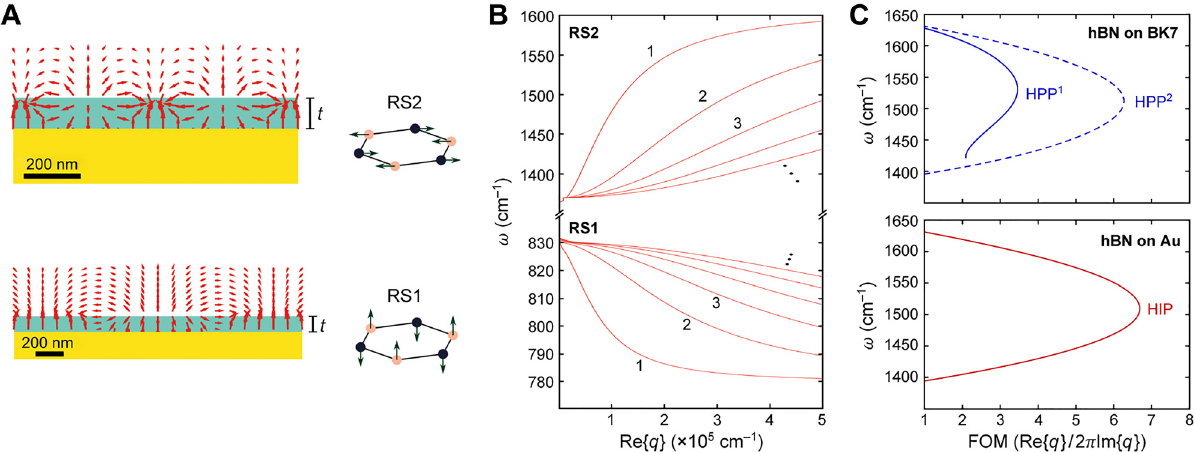
Figure 3: Image phonon-polaritons in a hBN slab. A Electric field distributions of the image phonon-polaritons and corresponding hBN phononmodesexcitedinthetwoReststrahlenbandsRS1(Re{ ε ⊥ }<0,Re{ ε // }<0 andRS2(Re{ ε ⊥ }<0,Re{ ε // }<0.BDispersionofimagemodes in the hBN slab waveguide, calculated for the two Reststrahlen bands and several mode orders. A,B Adapted with permission from [21]. the image modes in hBN on gold, calculated for the second Reststrahlen band which is experimentally accessible by